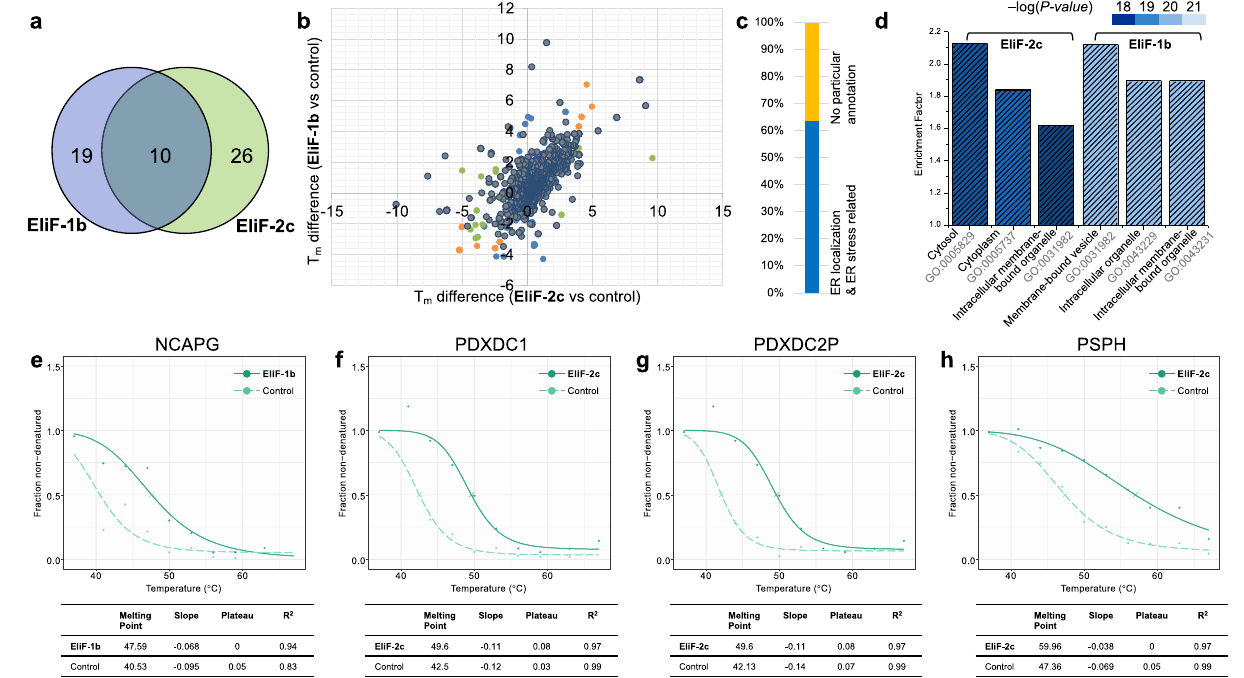
Fig. 6 | Label-free target identi fi cation for EliF-1b and EliF-2c. a A Venn diagram of target proteins identi fi ed by TPP. b T m shift plot of TPP with target proteins of EliF-1b inblue, EliF-2c ingreen,andthecommonhitsinorangecolor,respectively. c ER-related functionalannotationoftargetproteins. d Gene ontologyenrichment